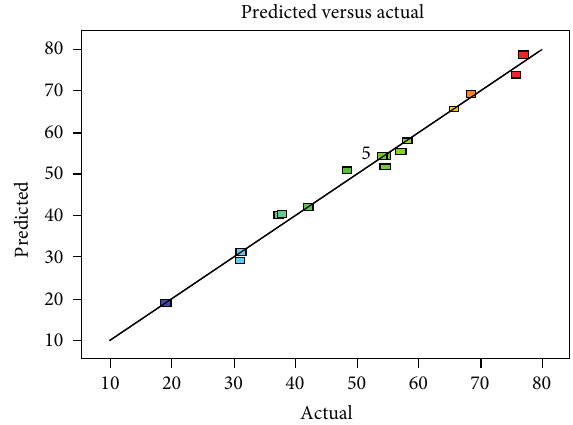
F 1: e actual and predicted plot for percentage removal of Cr(VI) ions using EAM-CCRCBs.